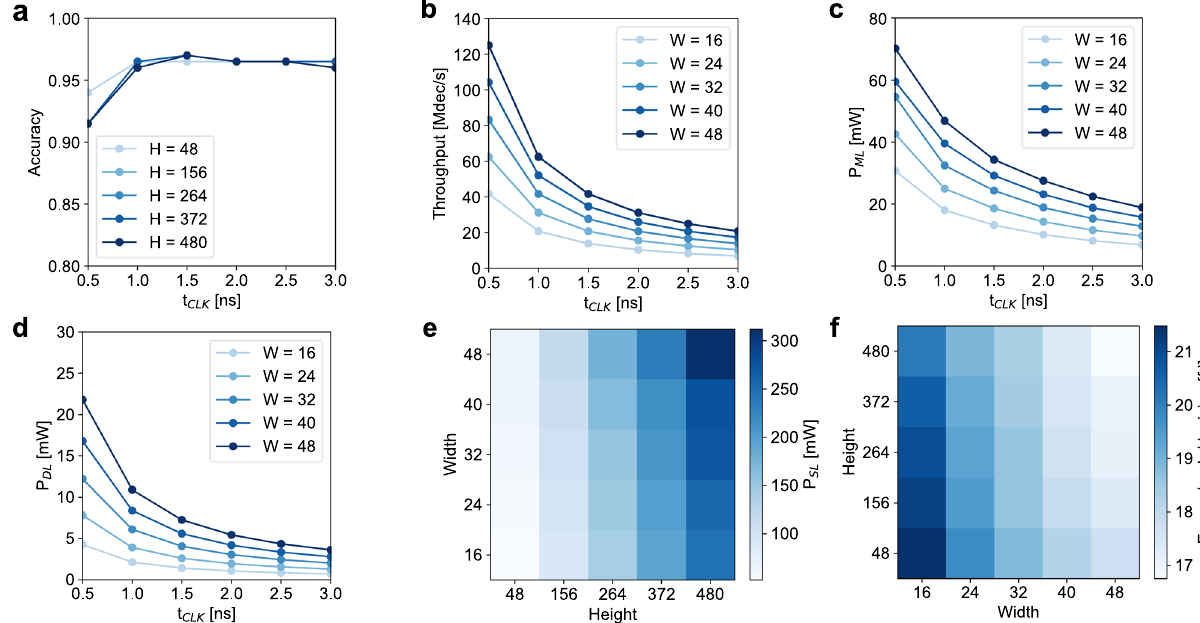
Fig. 5 Performance evaluation. a Classi fi cation accuracy as a function of t clk for different tile height H at fi xed tile width W = 16. Accuracy does not depend on H as expected, until for nominal operational frequency namely for t clk > 1 ns , below which mapping in the chosen conductance range is not possible. Throughput ( b ), ML dynamic power consumption ( c ) and DL dynamic power consumption ( d ) as a function of t clk for different W at fi xed H = 48. e SL